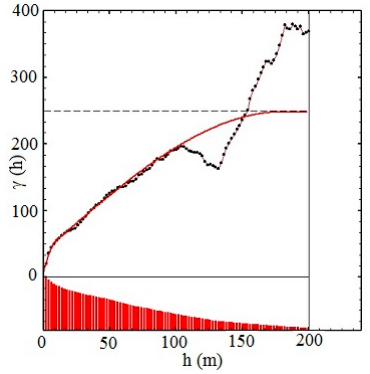
Figure 6. Vertical sample variogram (black points) and variogram model (red line) for regularized 2.0 m samples for the global model. Table 4. Cross-validation comparison using local and global models. 351